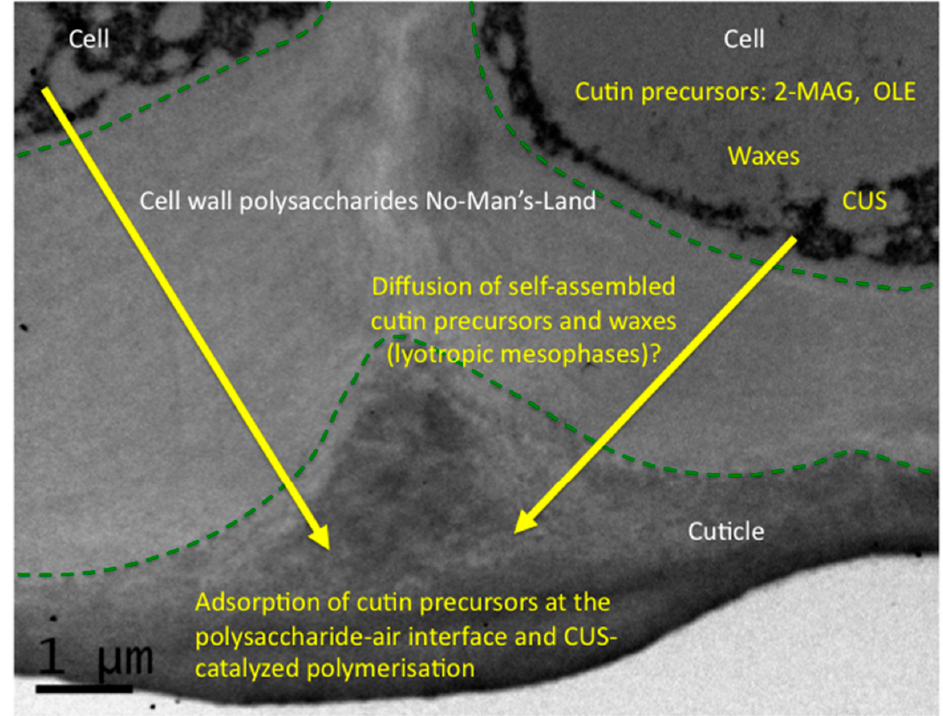
Figure 1. Extracellular formation of the cutin polyester in plant cuticles. Cutin monomers (2-MAG and-or OLE) are produced in the epidermal cells and are specifically polymerized within the cuticular layer. 2-MAG: 2-monoacylglycerol; OLE: cutin oligoesters; electron microscopy image of tomato exocarp at 20 days post-anthesis.